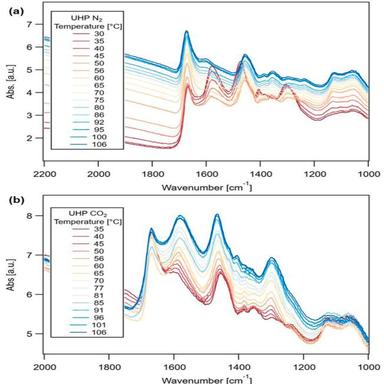
PM-IRRA spectra collected on PEI/MCM-41 as a function of temperature in (a) N2 and (b) CO2 atmosphere in the region of interest. Spectra were collected in 5 min intervals as the temperature was increased at a rate of approximately 1 ◦C/min.